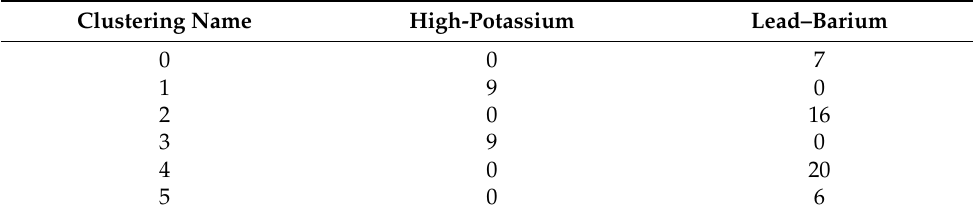
Table 3. Results of clusters by parent class obtained by K-Means++ clustering